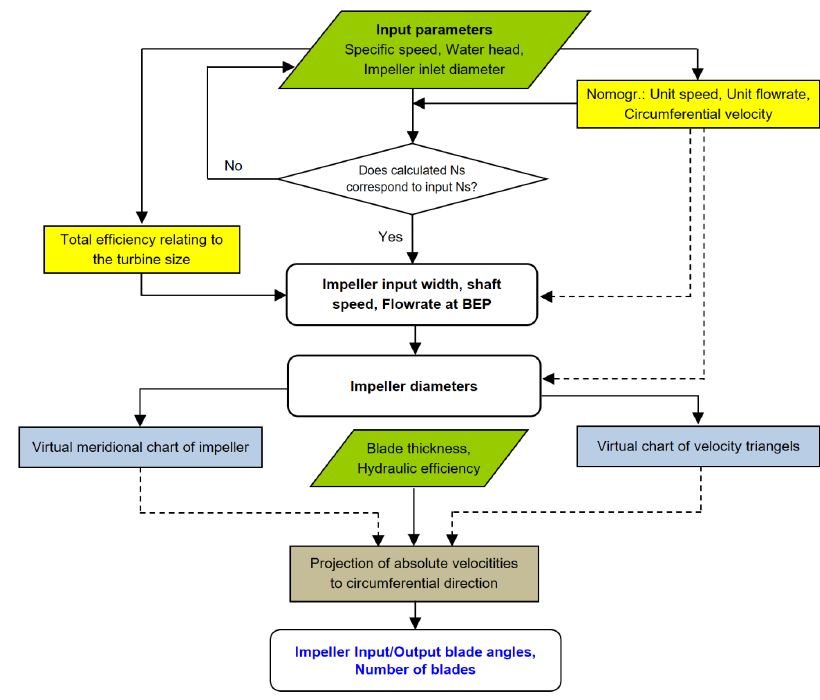
Figure 2. Algorithm of the impeller design in the calculation model.